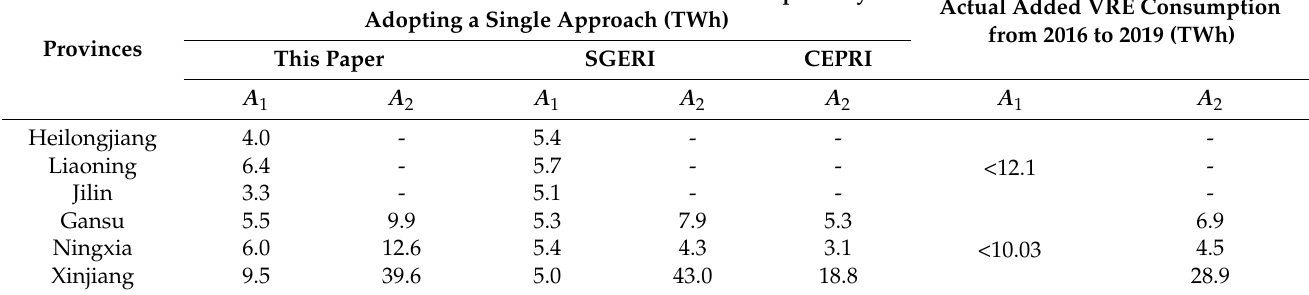
Table 6. Comparison among results from different methods: Added variable renewable energy (VRE) consumption by adopting a single